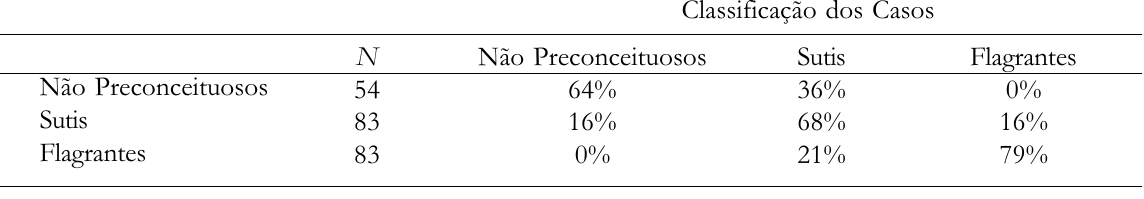
Tabela 6. Matriz de Classifica(cid:231)ªo ( Confusion Matrix ) dos Indiv(cid:237)duos Discriminados Corretamente e Incorretamente pelas Fun(cid:231)ıes